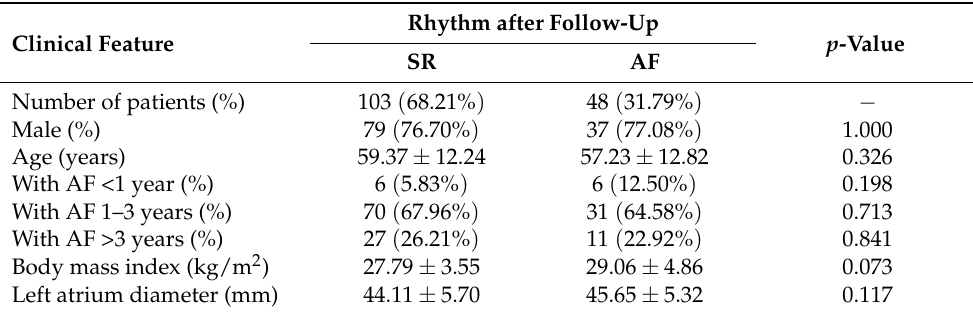
Table 1. Baseline clinical characteristics of the population enrolled in the study with their correspond- ing statistical significance to distinguish between the two groups of